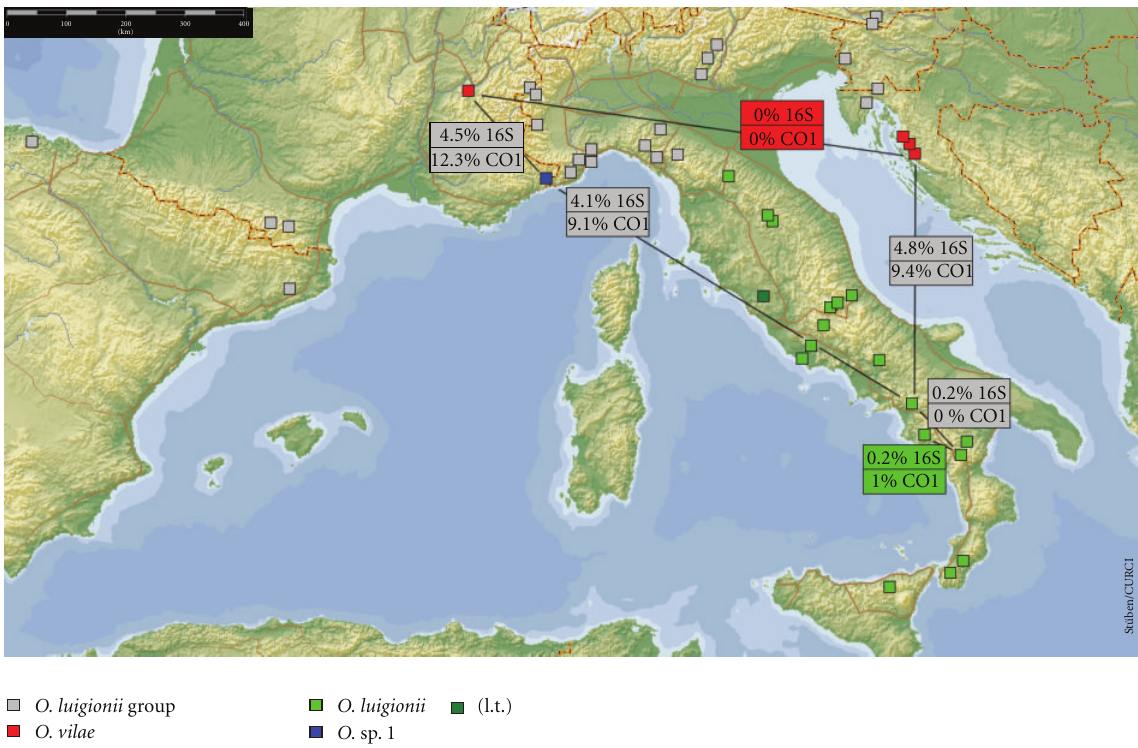
Figure 3: Distribution of related species of the O. luigionii group in the Mediterranean area with values of COI and 16S p-distances.